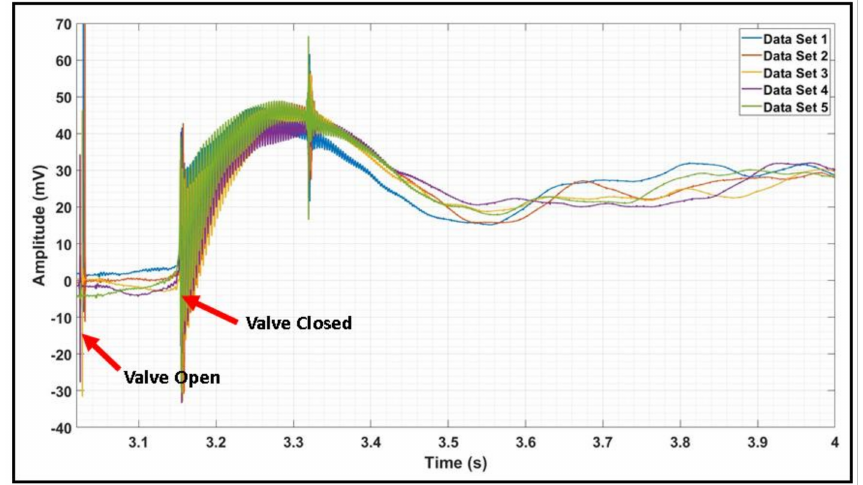
Figure 15. 5 mm active on Fire Hydrant 1 leak, 3.5 bar water pressure, raw data from field signal. Equation (12) is being used to determine the NIKAZ factor for each sequence of